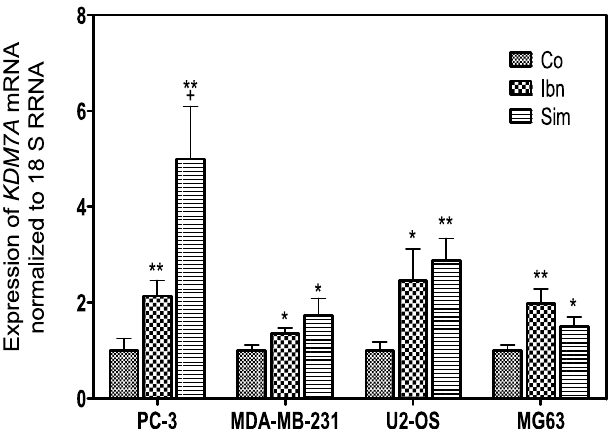
Figure 4. Effect of ibandronate (Ibn) and simvastatin (Sim) on the mRNA expression of the histone demethylase KDM7A . Bars represent the mean ± SD; * p ≤ 0.05, ** p ≤ 0.01, Control (Co) vs. treatment. † p ≤ 0.05, ibandronate vs. simvastatin; n = 3.